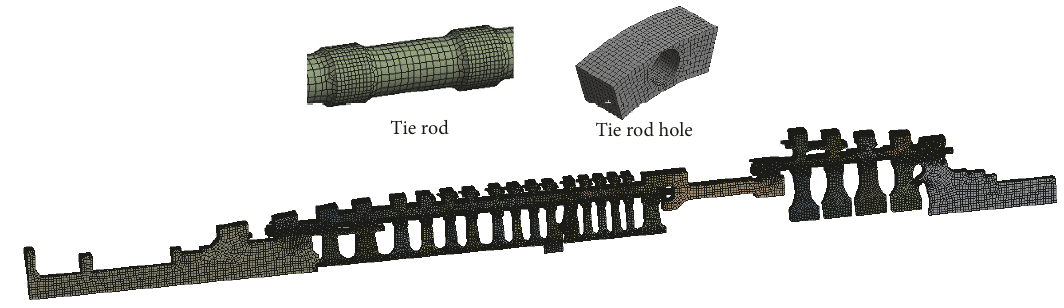
Figure 2: A one-twelfth cyclic symmetry three-dimensional finite element model of the gas turbine